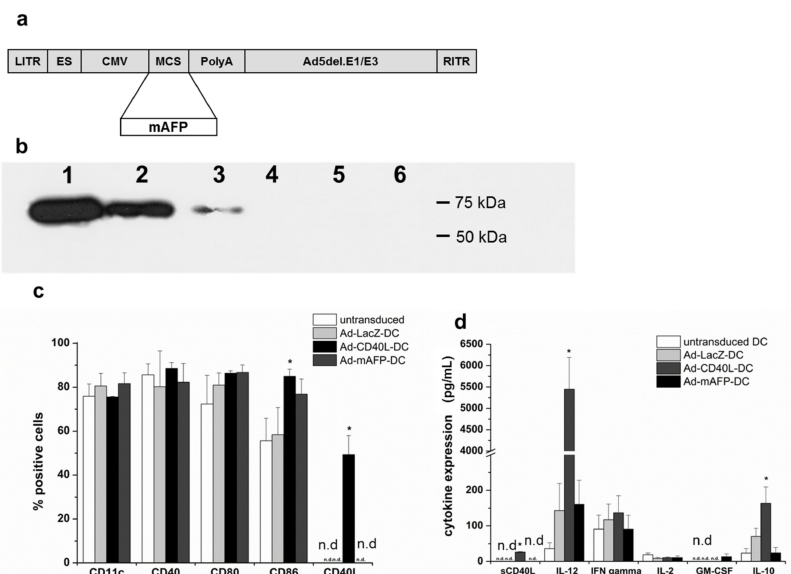
Figure 1. Characterization of Ad-mAFP and Ad-CD40L transduced DC. ( a ) Map of Ad-mAFP. LITR: left inverted terminal repeat; ES: encapsidation signal; CMV: cytomegalovirus immediate early promoter; MCS: multiple cloning site; PolyA: polyadenylation signal; Ad5del.E1/E3: human adenovirus type 5 sequence with deletion of E1-/E3-genes; RITR: right inverted terminal repeat. ( b ) Western Blot detecting mAFP- specific band 1: mAFP-positive Hepa1–6, 2: Ad-mAFP- transduced mDC (MOI 500), 3: Ad-mAFP-transduced mDC (MOI 100), 4: non-transduced mDC, 5: Ad-GFP-transduced mDC (MOI 500), 6: control adenovirus-transduced DC (MOI 500). Samples have equal amounts of protein. ( c ) Flow cytometry of maturation markers of DC 48 h after adenoviral transduction. The percentage of positive cells of the pre-gated CD11c-positive population was analyzed ( n = 4, * = p < 0.05 compared to Ad-LacZ-DC), n.d. = non detectable. Results represent means ± SD of three different experiments. ( d ) Cytokine amounts in the supernatant of DC 48 h after adenoviral transduction. n.d. = non detectable. Results represent means ± SD of three different experiments. (* p < 0.05 compared to Ad-LacZ-DC). Significance was determined using the